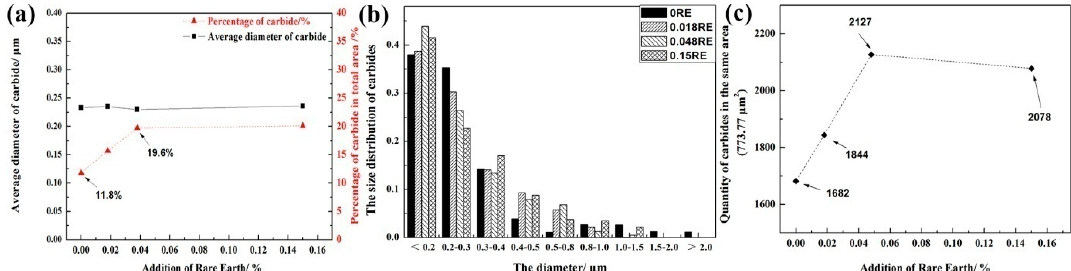
Figure 5. ( a ) Average diameter and percentage of the annealed carbides with different additions of RE; ( b ) The distributions of the annealed carbides with different additions of RE; and ( c ) The quantity of the annealed carbides in the same area (773.77 μ m 2 ) with different additions of RE.